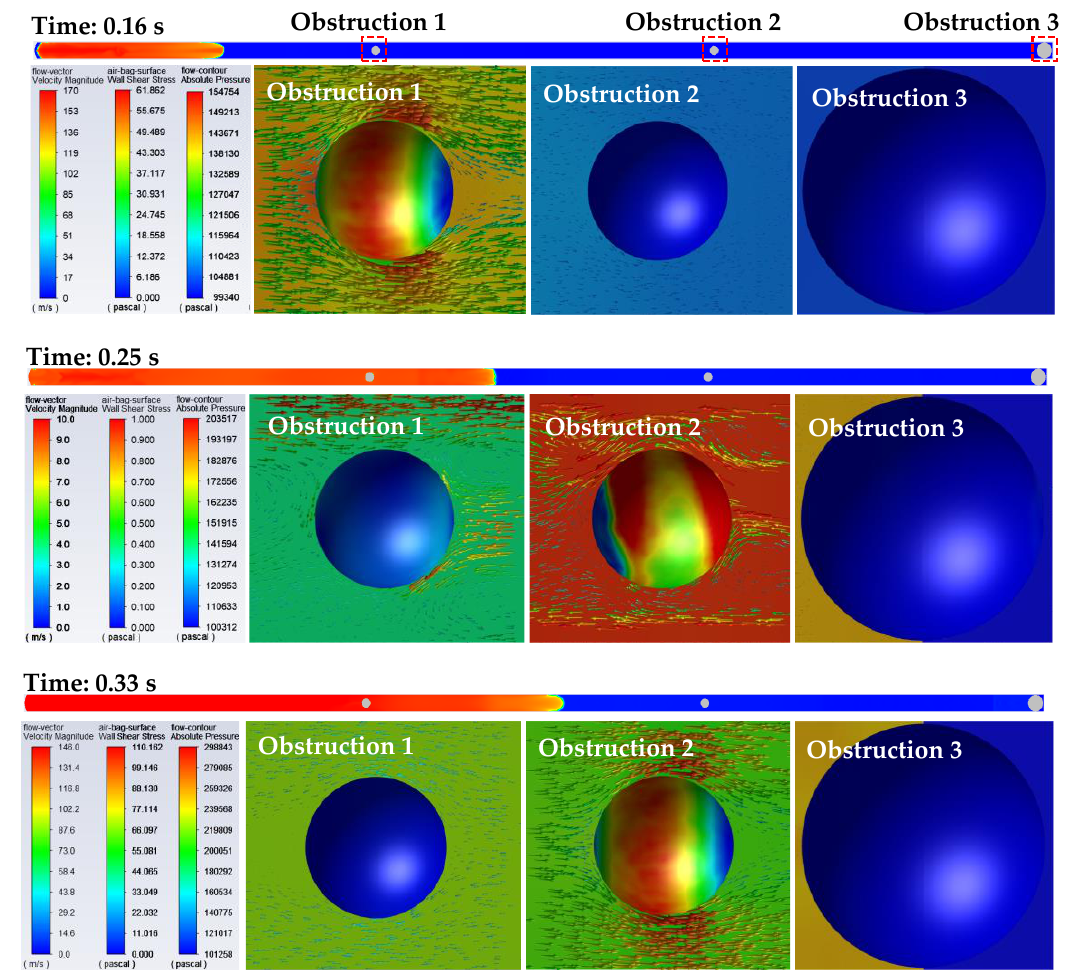
Figure 19. Flow field (flow vector and contour of pressure) and shear stress on the obstruction surface exerted by the air flow around the obstructions for the scenario where both Obstruction 1 and Obstruction 2 are half inflated, and Obstruction 3 is fully inflated (with a 100% blockage).